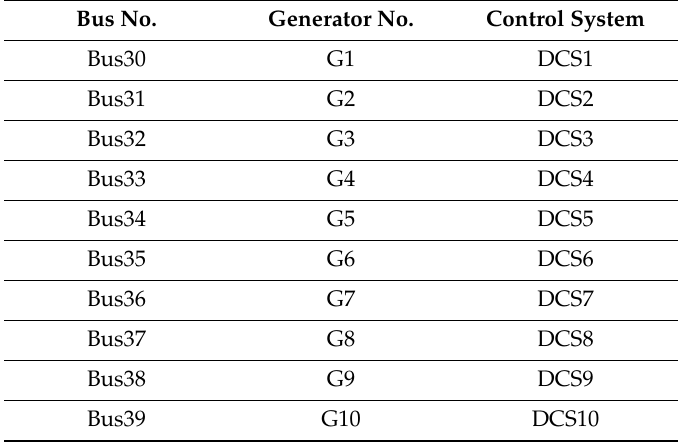
Table 4. Definition of a generator in the simulated